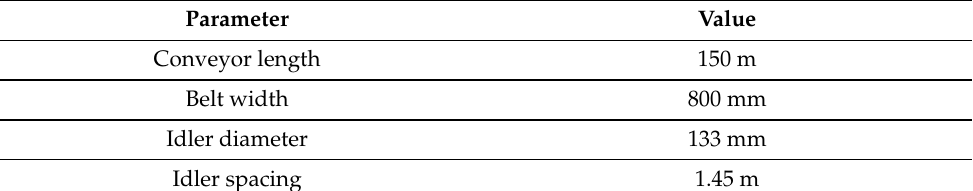
Table 2. Belt conveyor parameters.